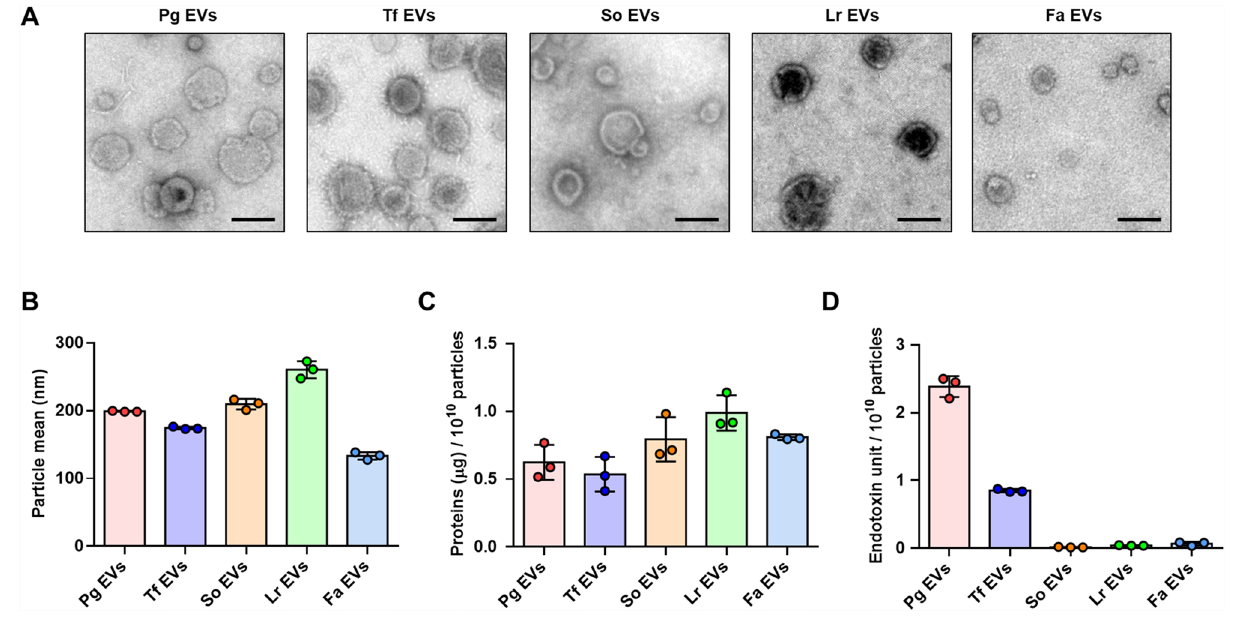
Figure 1. Characterization of bacterial EVs. ( A ) TEM photographs showing morphology of EVs released from P. gingivalis (Pg EVs), T. forsythia (Tf EVs), S. oralis (So EVs), L. reuteri (Lr EVs), and F. alocis (Fa EVs) (scale bar: 100 nm). ( B ) The mean size (nm) of EVs was analysed by NTA. ( C ) Proteins (μg)/10 10 particles of EVs. ( D ) Endotoxin unit/10 10 particles of EVs was measured by the LAL assay. Particle numbers and total protein amount (μg) were measured by NTA and BCA assay, respectively. The graphs show the mean values ± standard deviations of three biological